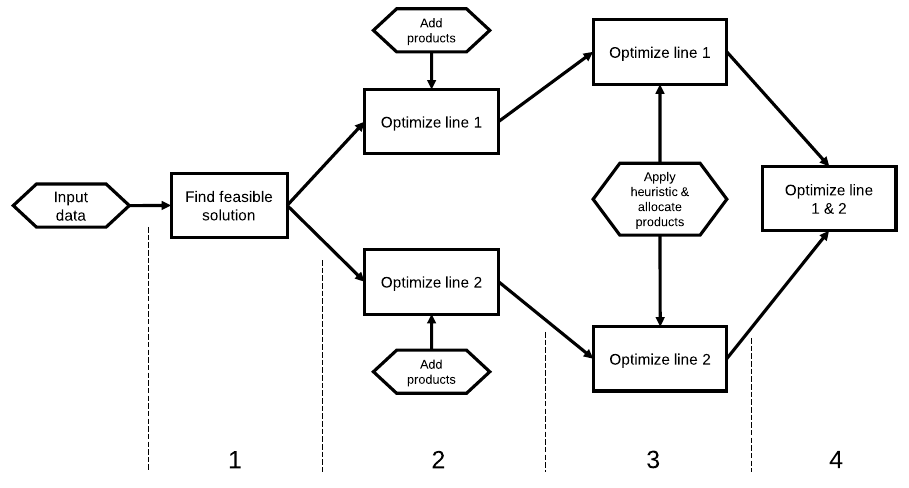
Fig. 4 Stepwise optimization